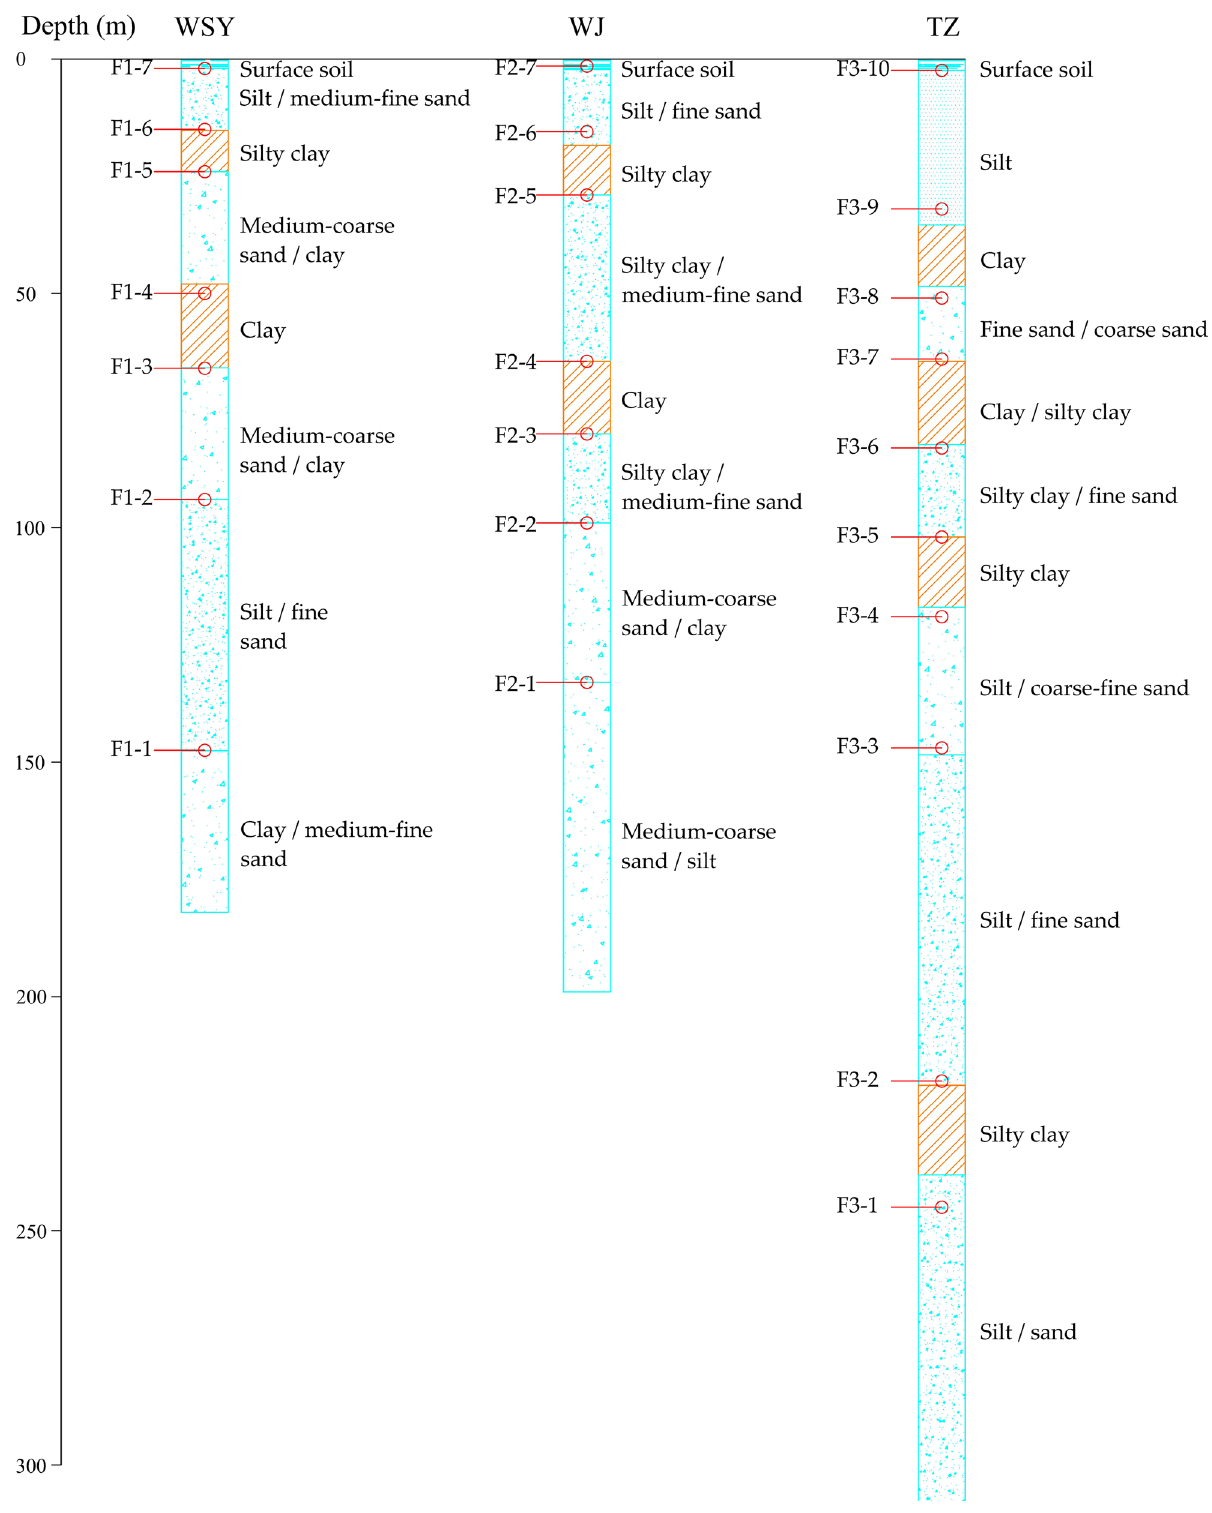
Figure 2. The observation layers of the extensometers and the corresponding lithology of the three monitoring